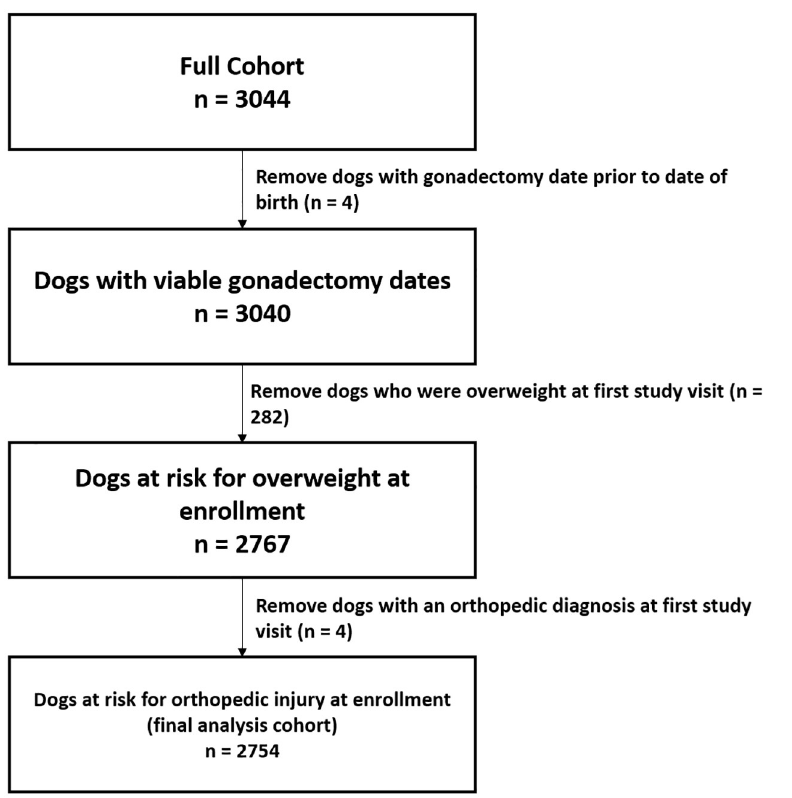
Fig 1. Summary of the analysis cohort used in the study of the association between age at gonadectomy and the risk for non-traumatic orthopedic injuries in the Golden Retriever Lifetime Study.